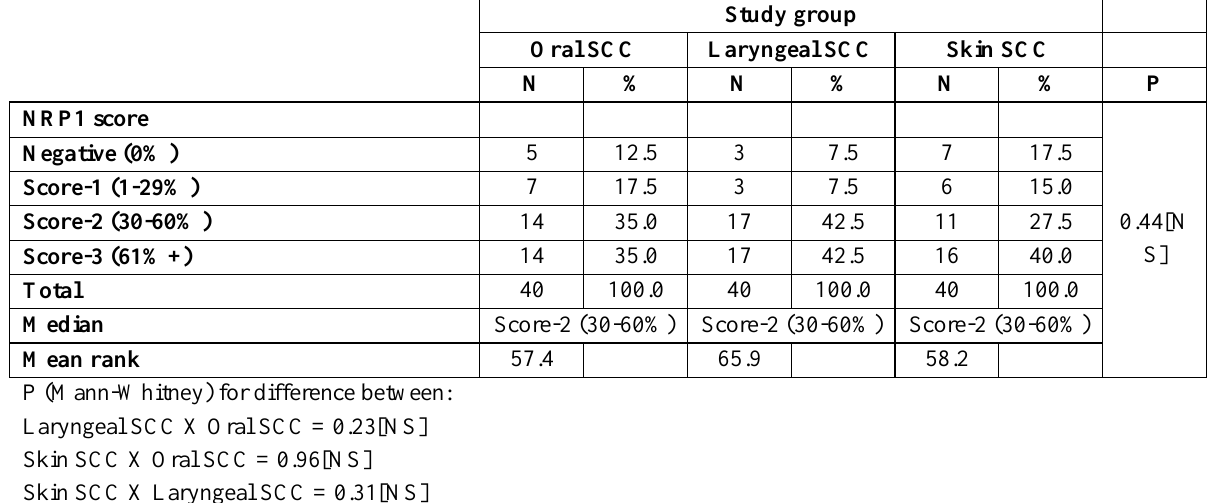
Table 3: The difference in median score category of NRP1 among the 3 study groups.